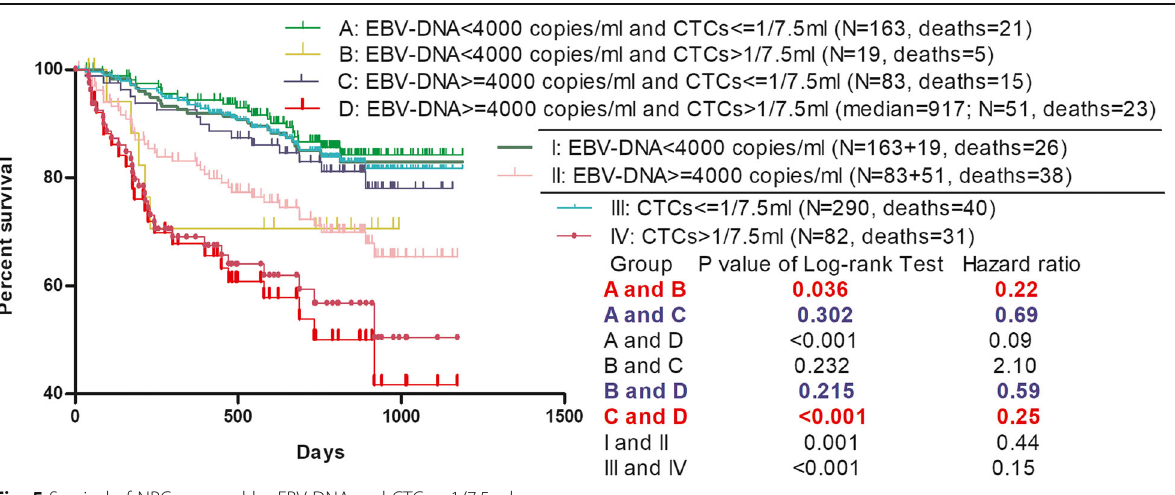
Fig. 5 Survival of NPC grouped by EBV-DNA and CTCs = 1/7.5